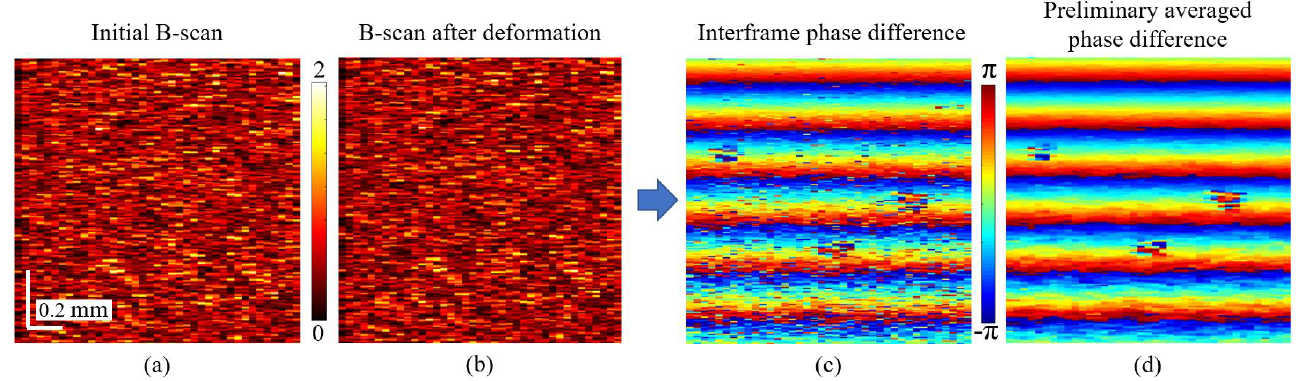
Figure 5. Simulated OCT images: ( a ) Structural B-scan before deformation; ( b ) B-scan after tissue deformation. B-scans are very similar and it is impossible to identify the vessels using only structural images. The pixel-to-pixel interframe phase difference between B-scans is shown in ( c ), and ( d ) represents this difference in a less noisy form due to vector averaging over a small window 2 × 2 pixels. The scale bar is 0.2 mm.